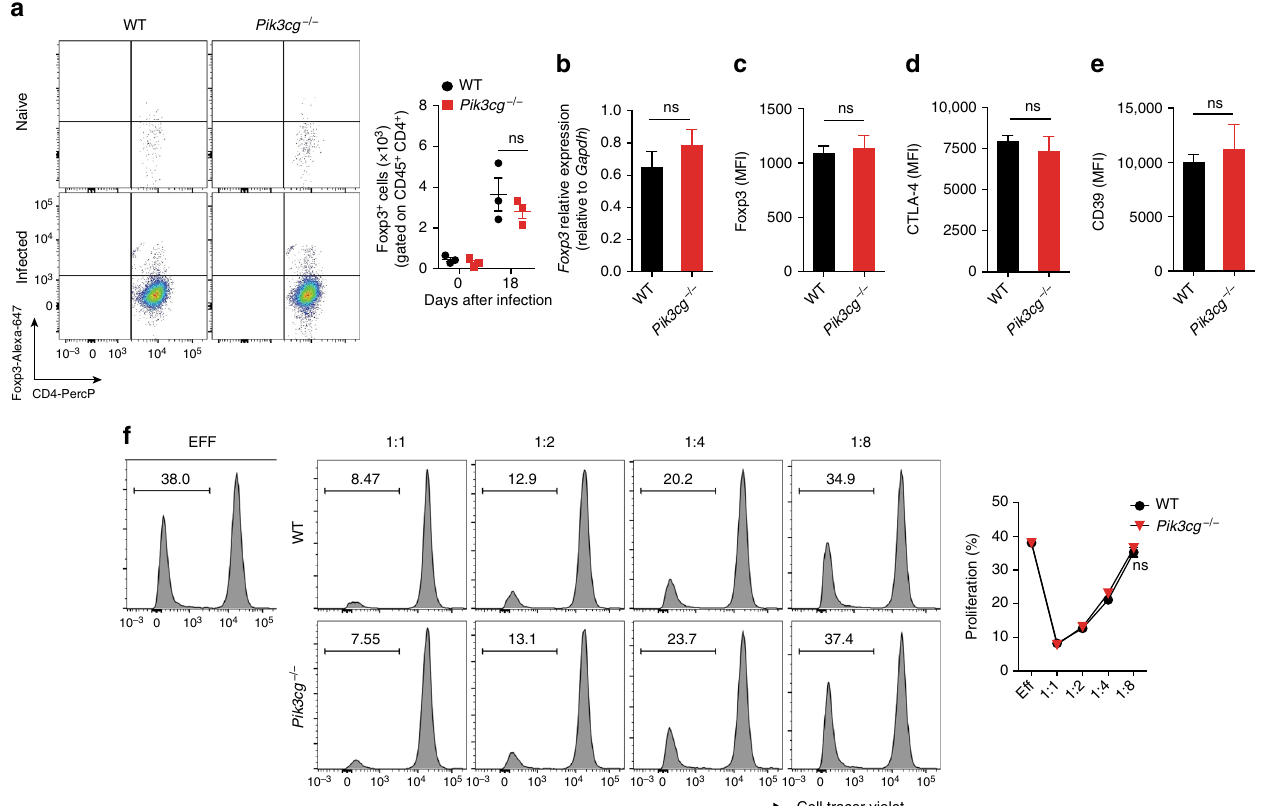
Fig. 5 The absence of PI3K γ does not affect the number and suppressive function of regulatory T-cells in the heart tissue of infected mice. a Representative fl ow cytometry plots for the analysis of Foxp3 staining and quanti fi cation of the number of positive cells in the heart tissue of WT ( n = 4) and Pik3cg − / − ( n = 3) naive mice or infected with T . cruzi Y strain. b PCR analysis of mRNA expression of Foxp3 gene in the heart tissue of WT ( n = 4) and Pik3cg − / − ( n = 4) mice. Gapdh was used as a housekeeping gene. c – e Flow cytometry analysis measured by the mean fl uorescence intensity (MFI) of the cell surface markers Foxp3 ( c ), CTLA-4 ( d ), and CD39 ( e ) expressed in CD4 + Foxp3 + cells from the heart tissue of infected of WT ( n = 4) and Pik3cg − / − ( n = 4) mice 18 days after infection with 10 3 trypomastigote forms of T . cruzi Y strain. f In vitro T-cell suppression by Treg cells isolated from the lymph nodes of WT and Pik3cg − / − naive mice. ns = no statistical signi fi cance (unpaired Student ’ s t- test in a – f ). Data are from one experiment ( f ) or representative of two ( a – e ) independent experiments (mean ± s.e.m in a – f